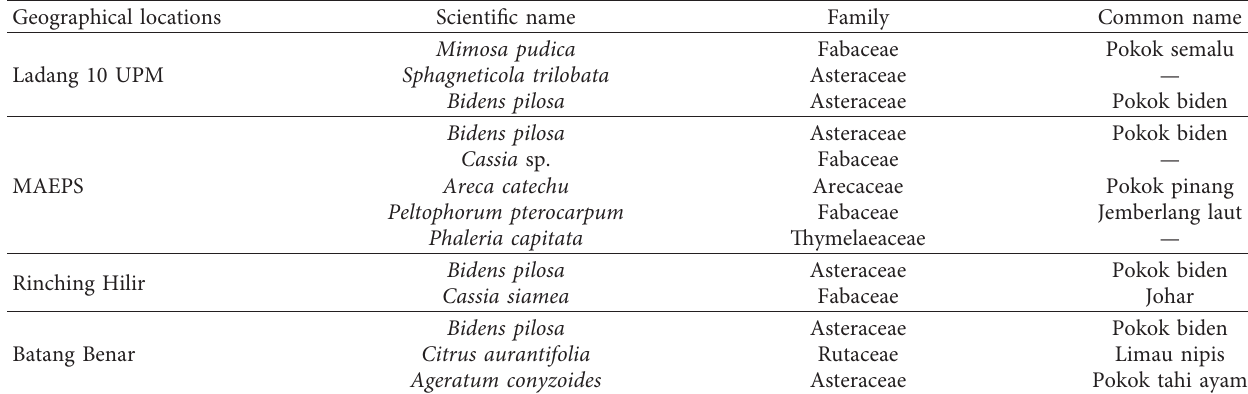
Table 1: Melissopalynological analysis of pollen from H. itama bee bread based on different geographical locations. Geographical